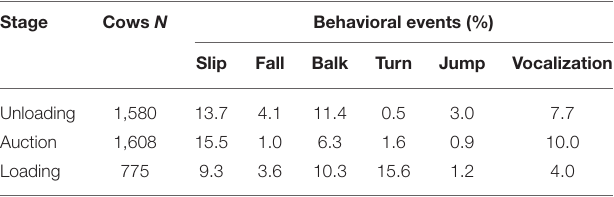
TABLE 2 | Descriptive analysis of behavioral events observed in the cows during unloading, auction and loading at the livestock markets. Stage